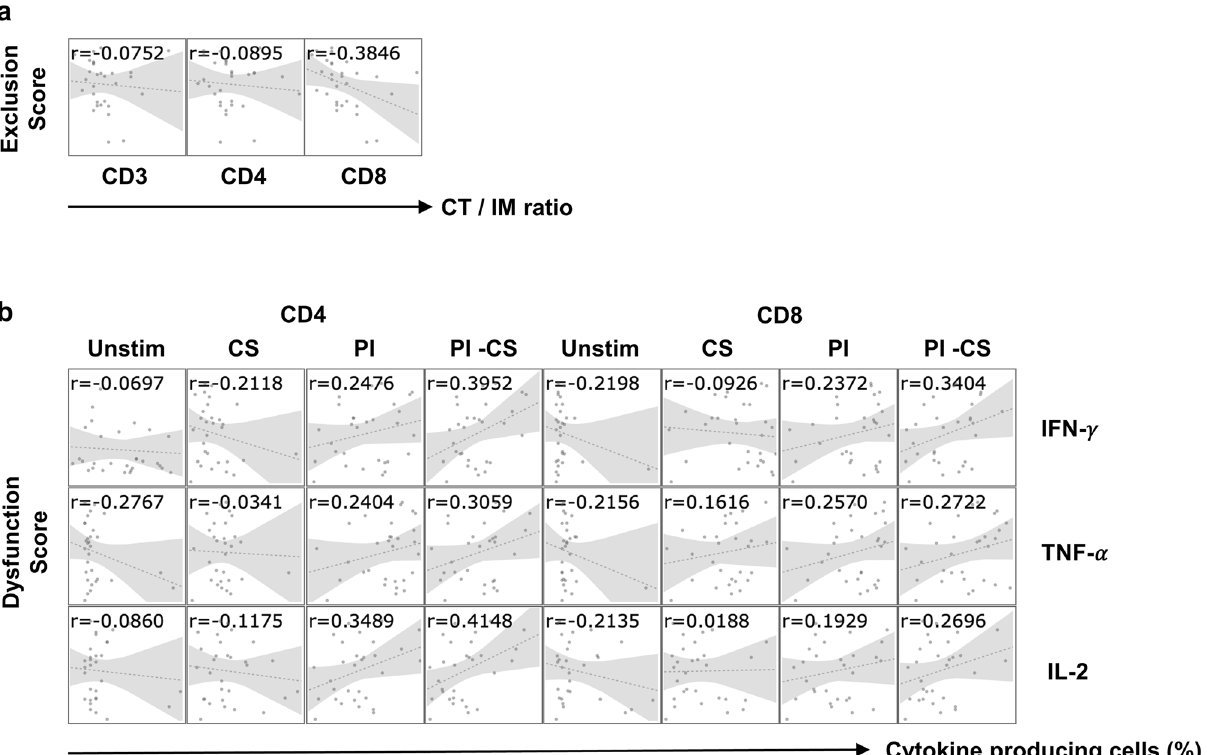
Figure 2. Correlations between TIDE scores and IHC or FCM. T cell dysfunction and exclusion scores were calculated on the TIDE website (http:// tide. dfci. harva rd. edu/). ( a ) The vertical axis shows the exclusion score. The horizontal axis shows the ratio of cell densities at CT versus IM of the following antibody-positive cells in IHC; CD3, CD4 and CD8. ( b ) The vertical axis shows the dysfunction score. The horizontal axis shows the percentage of cytokine (IFN-γ, TNF-α, IL-2)-producing CD4 + or CD8 + T cells without stimulation (Unstim), with CytoStim stimulation (CS), or PMA/IM (PI) stimulation, as detected by FCM. In addition, the difference between cytokine-positive cells with PI- and CS-stimulated cells was calculated in each patient and compared (PI-CS). The Pearson’s correlation coefficient (r) between dysfunction scores and the percentages of cytokine- producing cells is shown in the upper part of each scatter